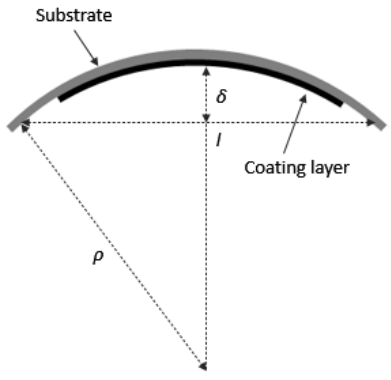
Figure 4. Schematic view of BMSB modeling.